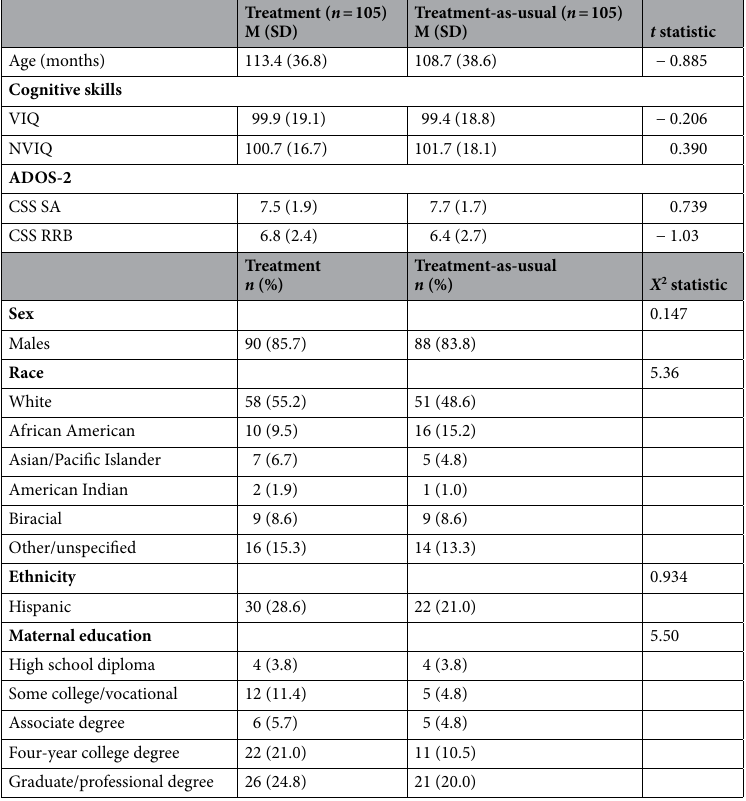
Table 3. Baseline demographic characteristics. Race was not reported for 3 participants in the treatment group and 9 participants in the treatment-as-usual group. Ethnicity was not reported for 22 participants in the treatment group and 29 participants in the treatment-as-usual group. Maternal education level was not available for 30 participants in the treatment group and 54 participants in the treatment-as-usual